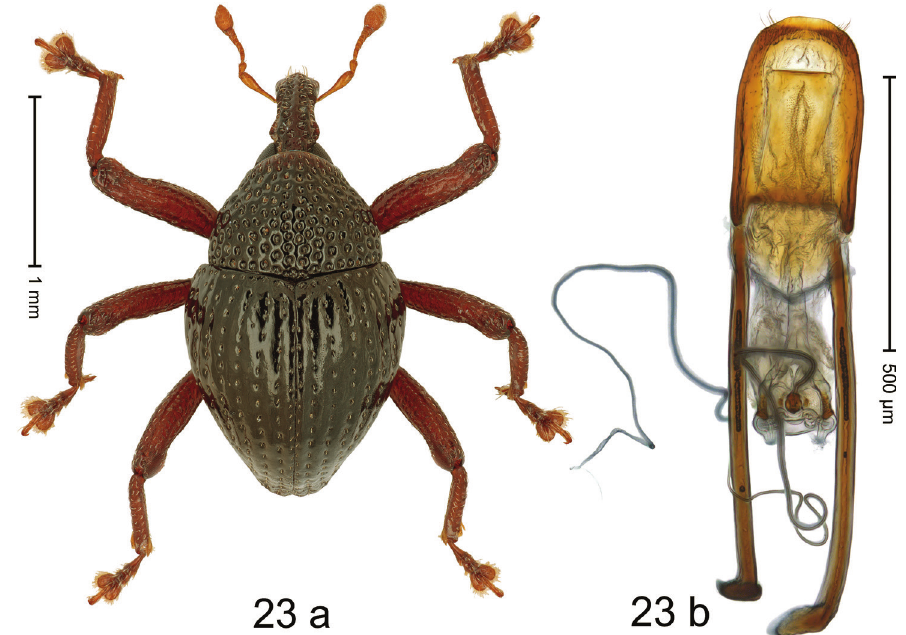
Figure 23. Trigonopterus tanah sp. nov., holotype a habitus b